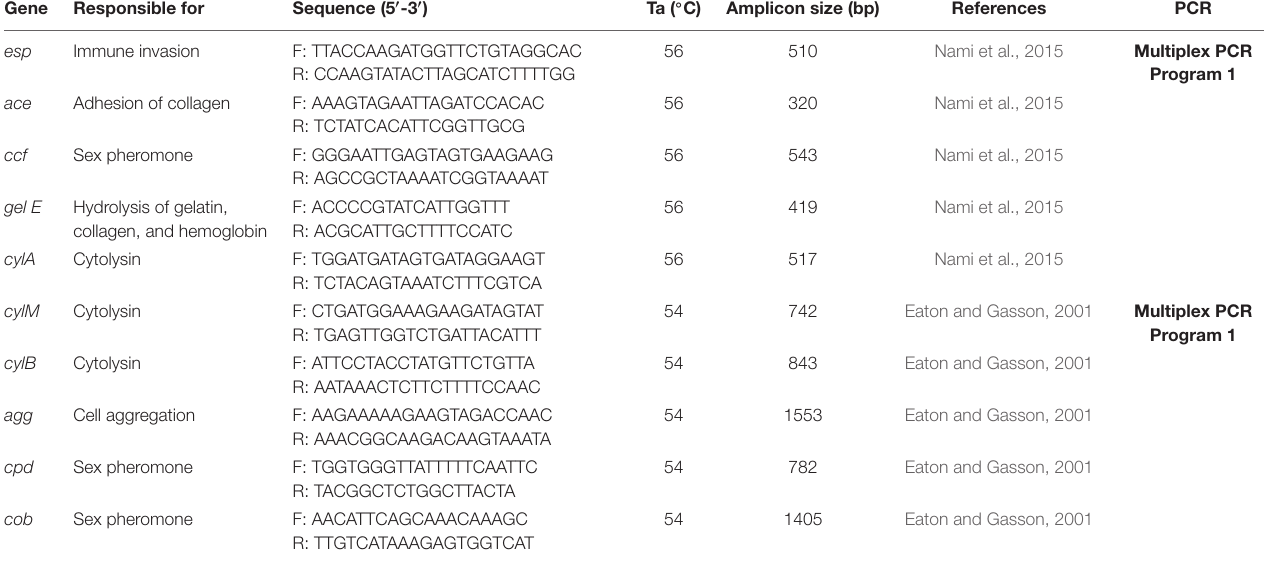
TABLE 2 | Primers used for PCR amplification of virulence